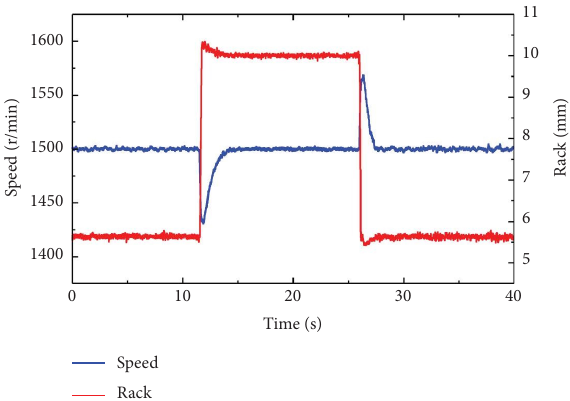
Figure 21: Experimental results of load sudden change for the ADRC algorithm.